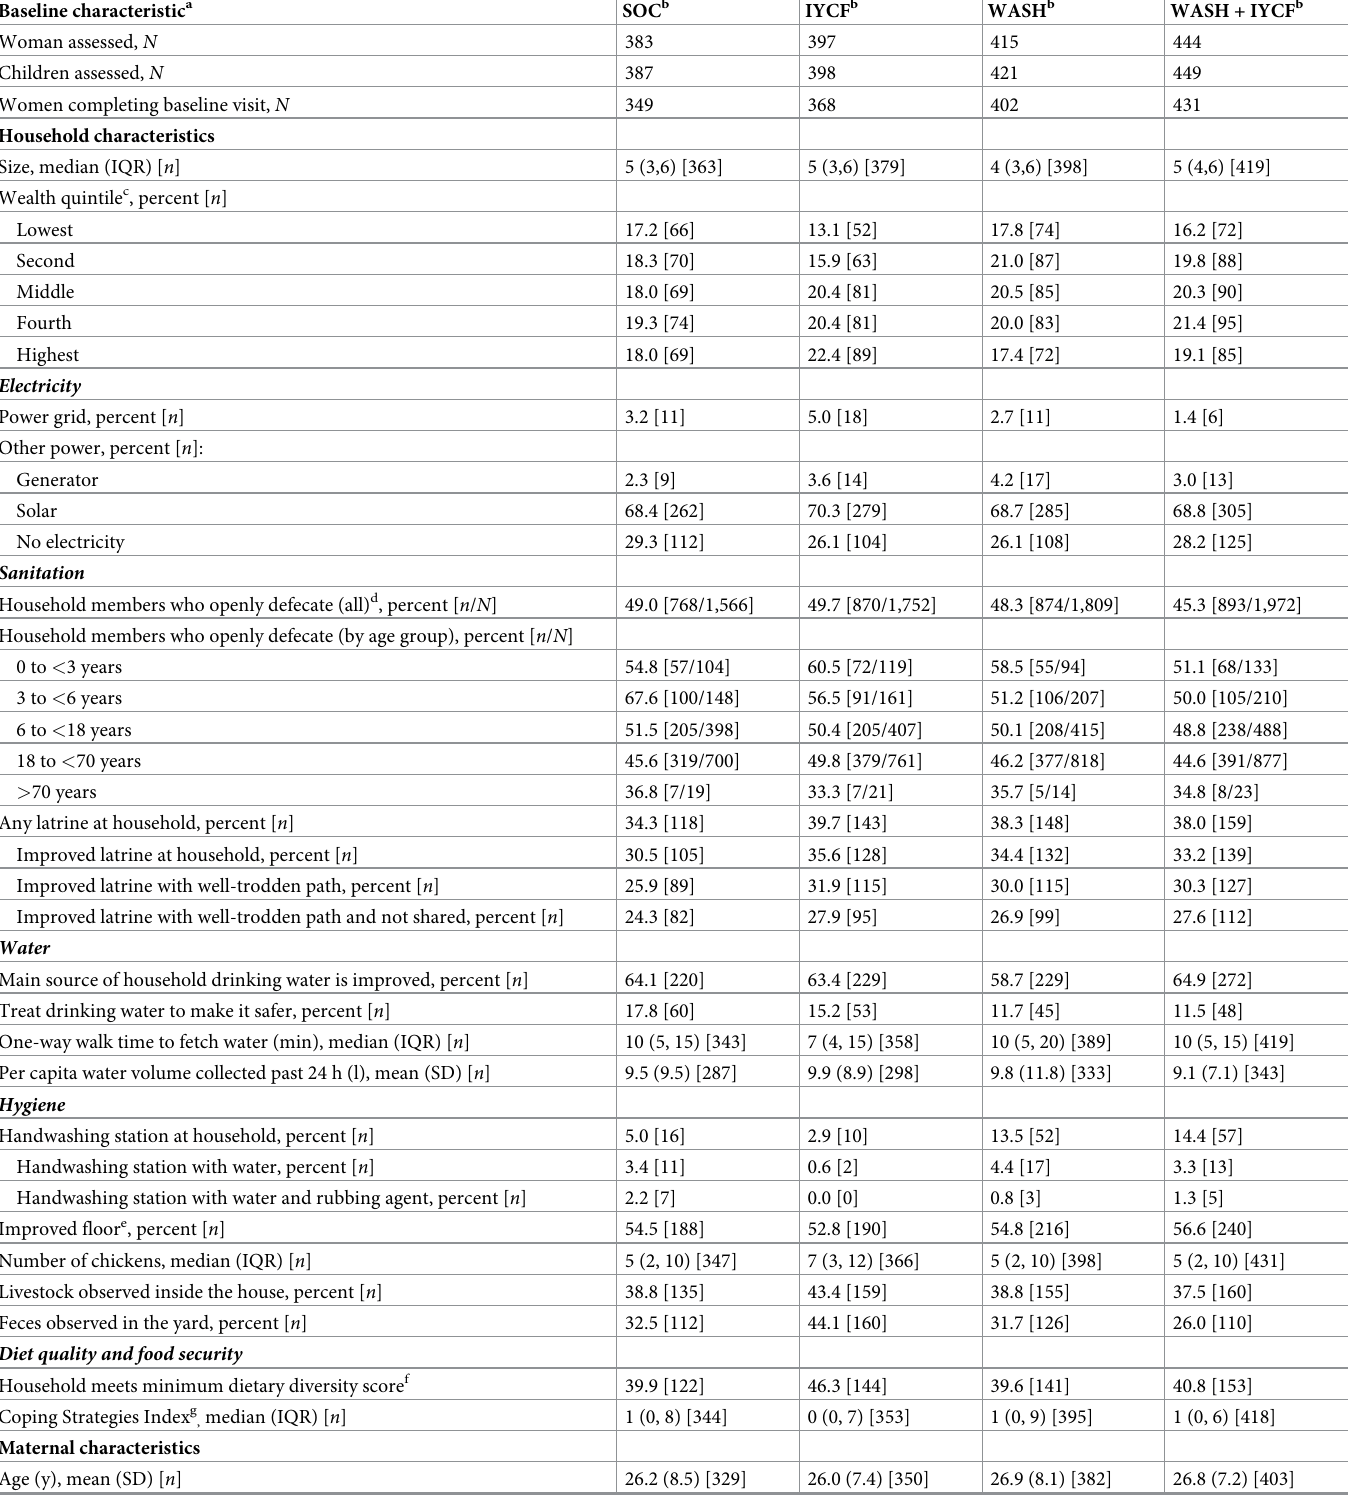
Table 2. Baseline characteristics of mothers and children in the early child development